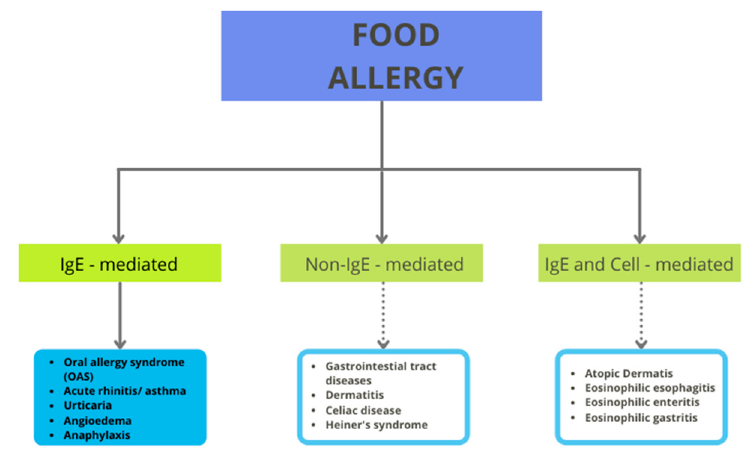
Figure 1. Classification of food allergy.